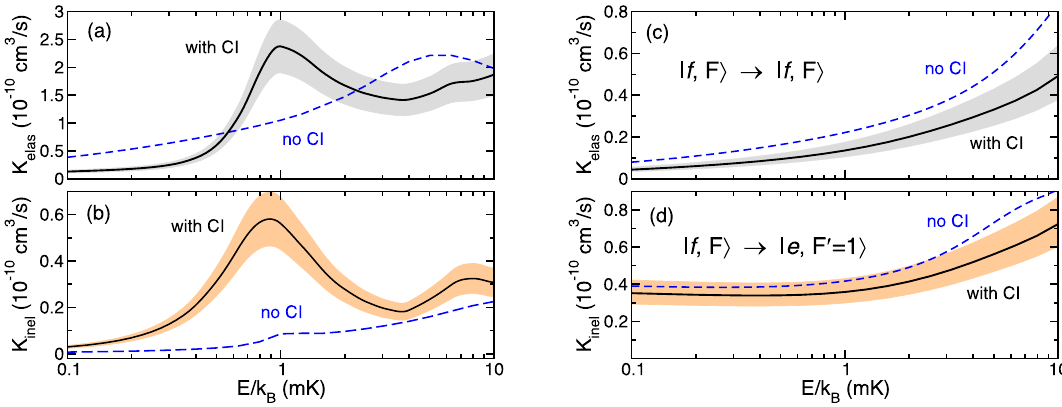
Figure 7. Collision energy dependence of the total elastic, panels ( a , c ), and inelastic, panels ( b , d ), rate 16 O 1 H with v 0, J 3 / 2 16 OH ( X 2 � 3 / 2 ) . Solid and dashed lines indicate results coefficients for 88 Sr + = = of coupled-channels calculations with and without conical intersection between 1 2 A ′ and 4 2 A ′ potentials, 0 rotational states up to J 25 / 2 are included. The grey and orange bands reflect our respectively. OH v = = estimate of the one-standard deviation uncertainty of the rate coefficient due to our inability to include all rotational states of OH when the CI is included in the calculations. Panels ( a , b ) show total elastic and partial 2 e F inelastic hyperfine quenching rate coefficients for OH in its hyperfine state, whereas panels ( c , d ) | ; = � 1 2 f F f F show rate coefficients for OH in its and hyperfine states. Rate coefficients for | ; = � | ; = � 2 f F are indistinguishable on the scale of the | ; = �